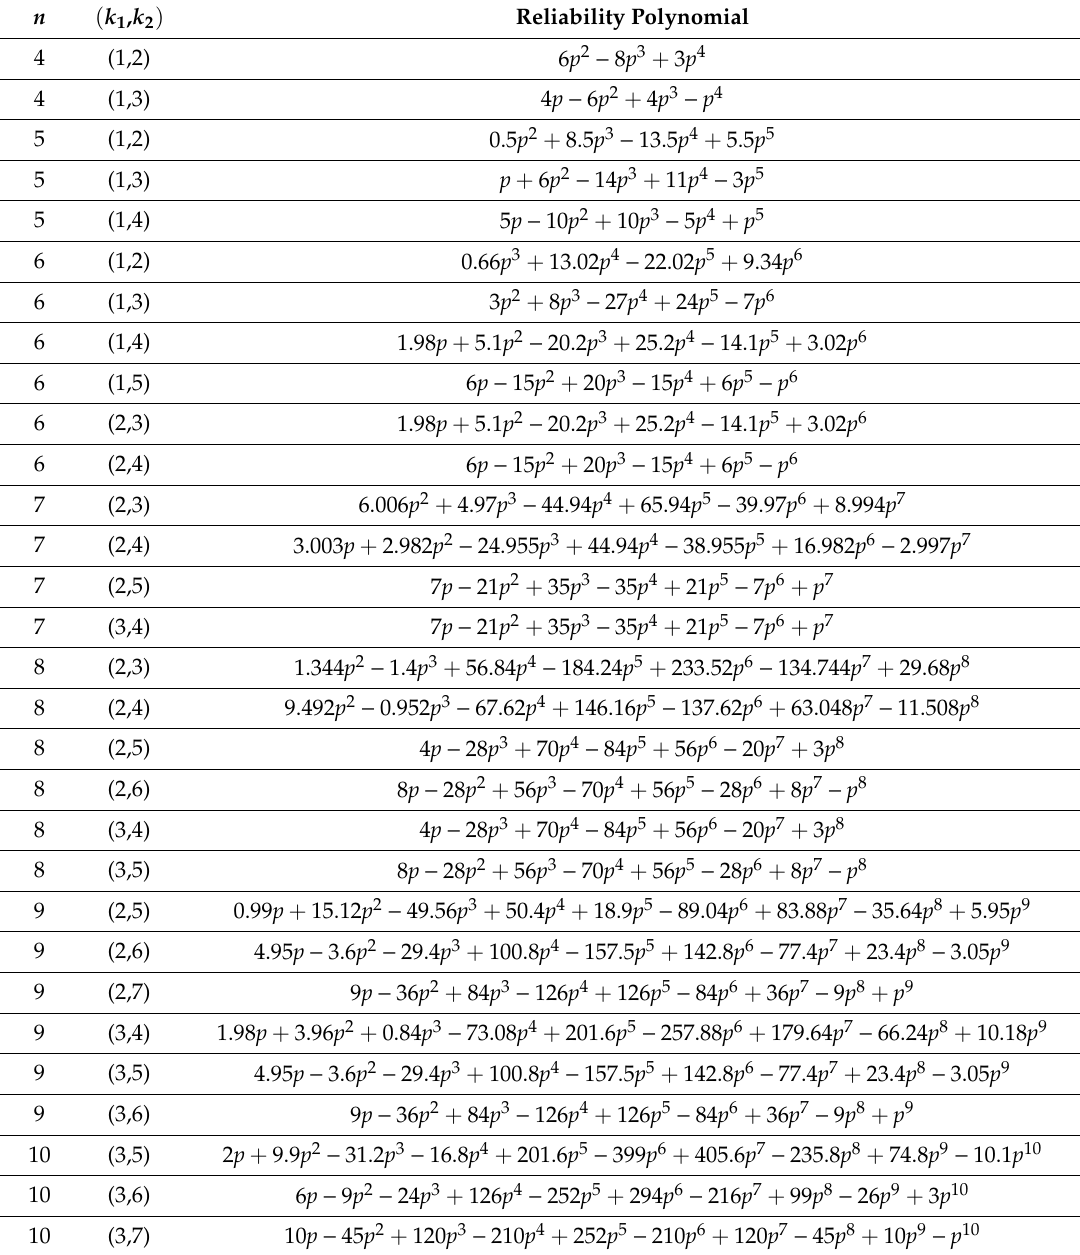
Table 1. Reliability polynomial of consecutive- k 1 and k 2 -out-of- n systems for di ff erent values of n , k 1 , k 2